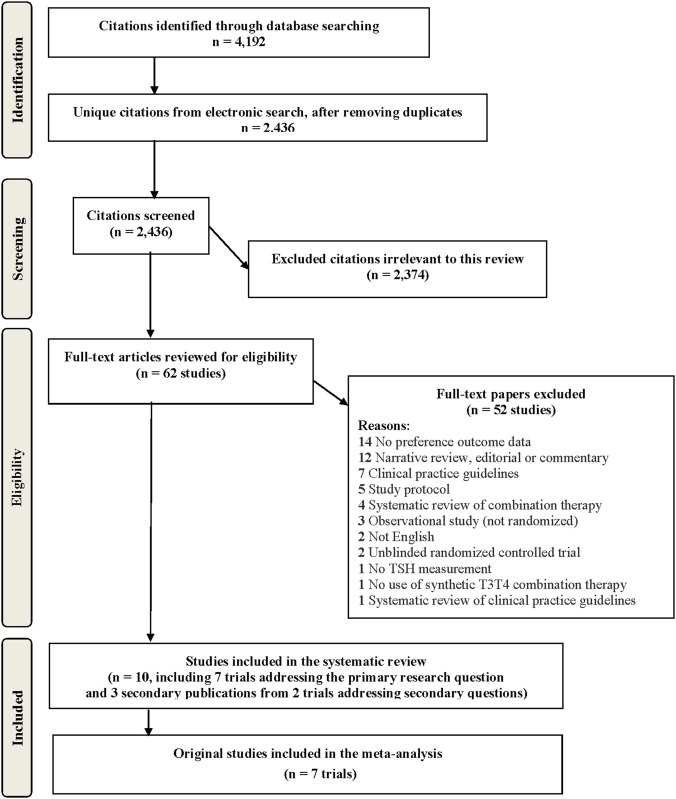
Study flow diagram.